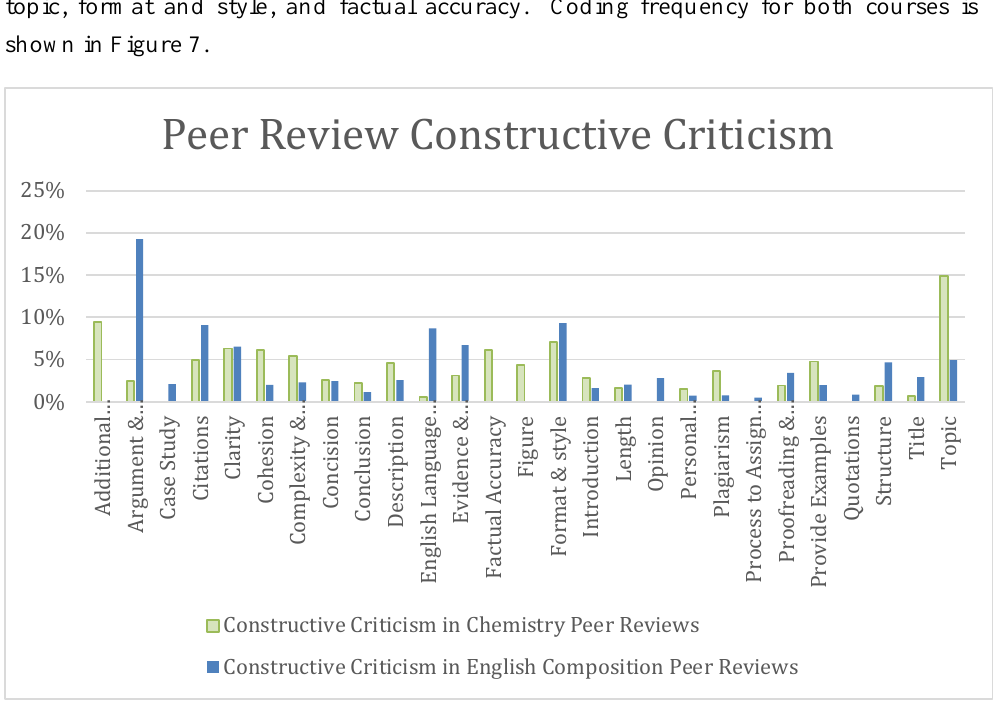
Figure 7. Constructive criticism writing elements in peer review open ended questions by course.